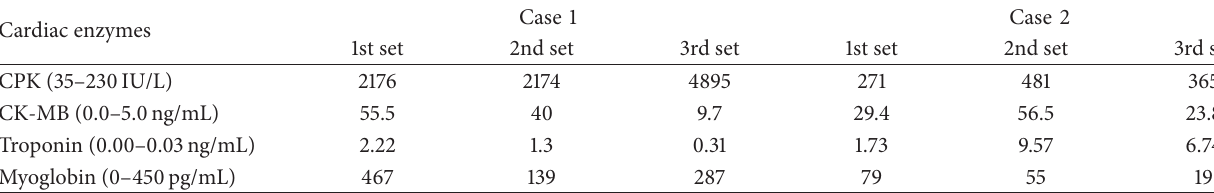
Table 1: Laboratory data of cardiac enzyme trends.